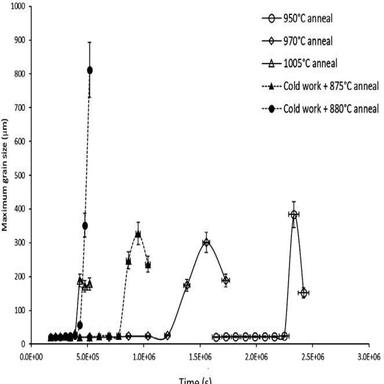
Dispersion parameter (Z) vs annealing time (t) for samples treated under various annealing conditions.